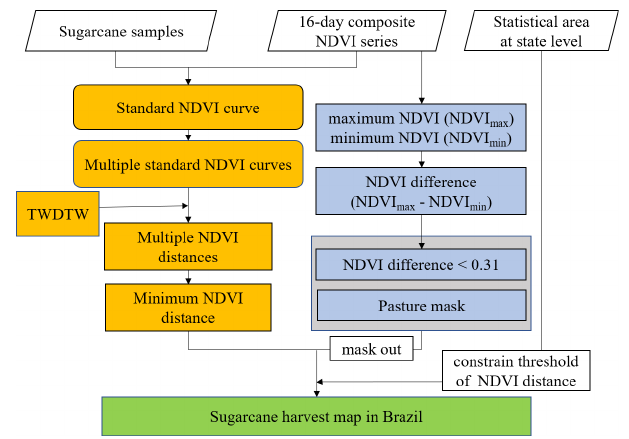
Figure 5. The workflow by employing the TWDTW method for sugarcane harvest area mapping.